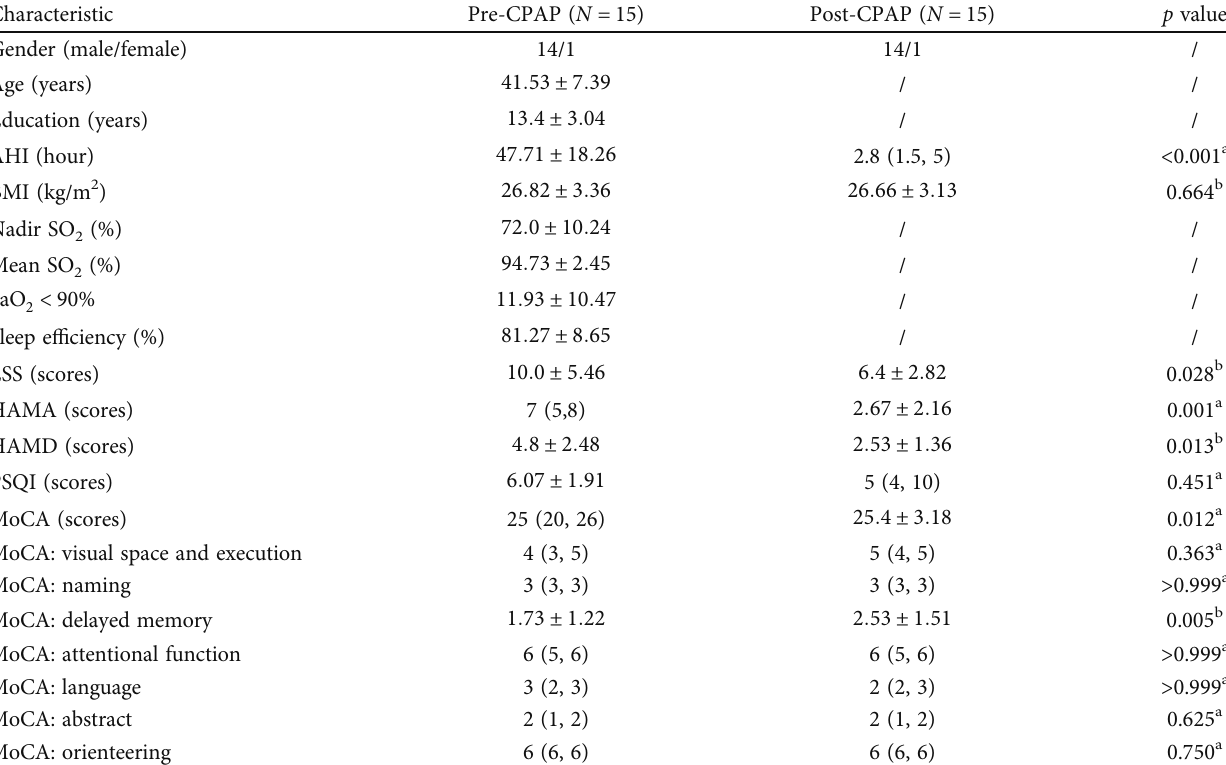
Table 1: Population and clinical characteristics of participants.